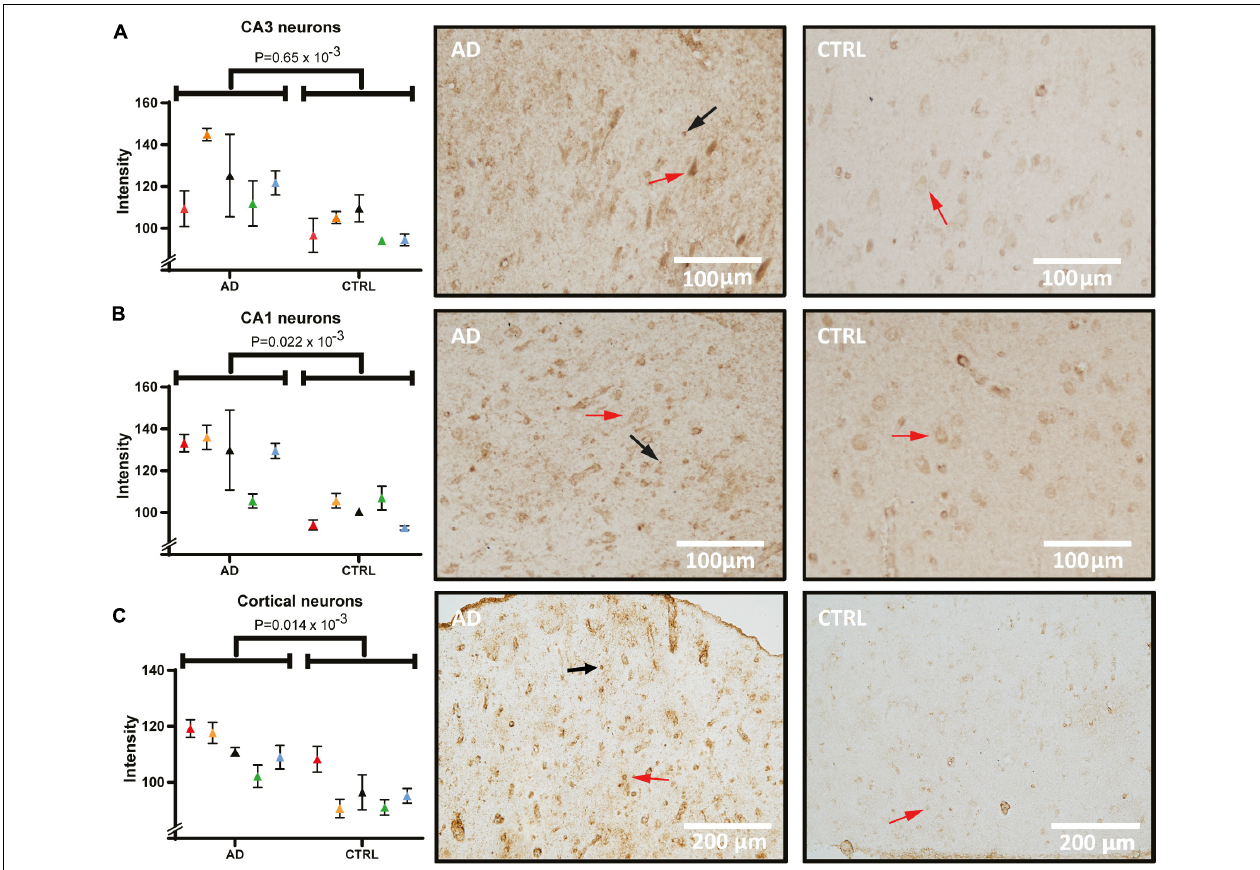
FIGURE 4 | 14-3-3- γ levels and distribution in pyramidal cells of the hippocampus and frontal cortex of AD and control. Panel (A) shows staining intensity of 14-3-3- γ in CA3 neurons quantified and compared between AD and control group, and tissue examples from one AD and one control case. Panel (B) shows staining intensity in quantified CA1 neurons and examples of analyzed images. Panel (C) shows frontal cortex quantification and staining. Individual patients are indicated by colors in the graphs. Examples of pyramidal cells and glia cells are indicated by red and black arrows respectively. AD, Alzheimer’s disease; CA1, cornu ammonis